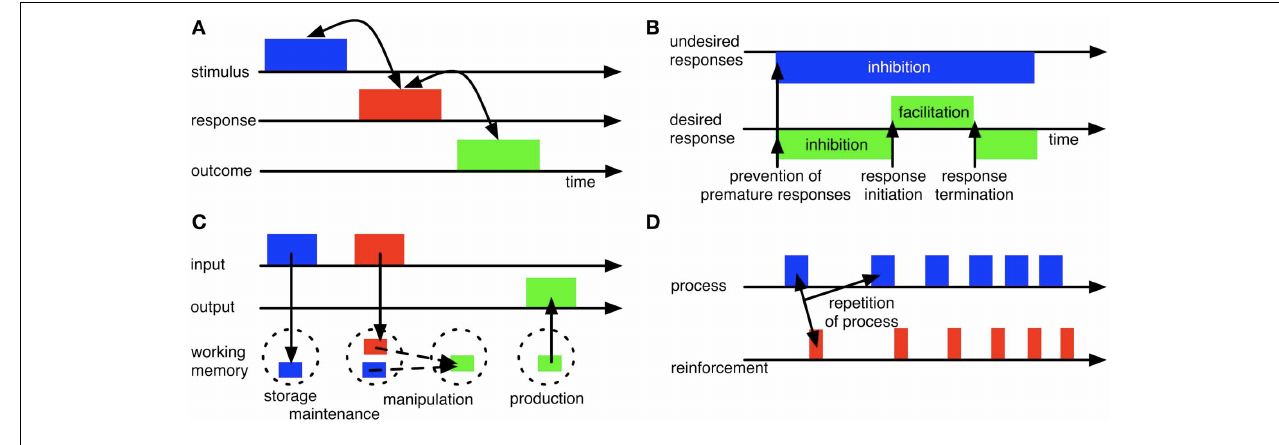
FIGURE 3 | Some influential concepts of BG functions. (A) BG may establish and maintain associations between stimuli and responses (or even between stimuli, responses and outcomes; Redgrave and Gurney, 2006) to allow context-based response selection. (B) BG may contribute to motor timing by providing initiation and termination signals for movements (Nambu, 2004) and by inhibiting premature responding (Frank, 2006). (C) BG may contribute to working memory functions, including gating of information into